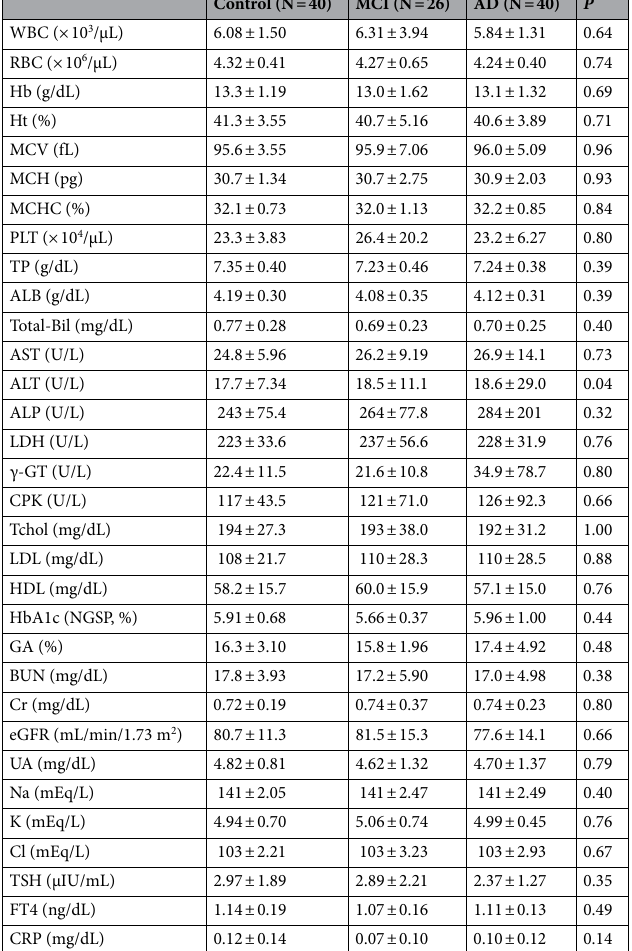
Table 2. Participant characteristics (Blood